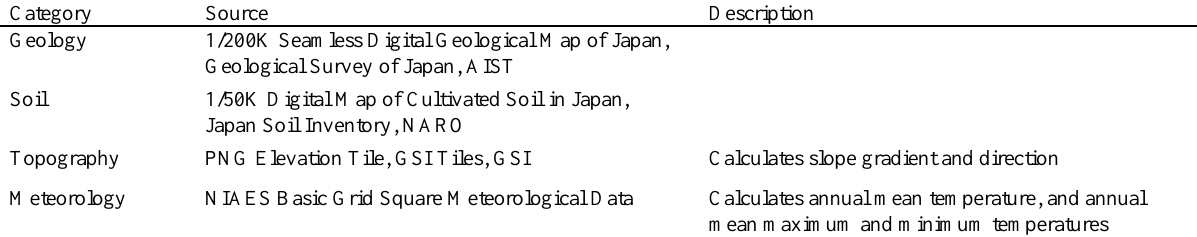
Table 1 Data categories and source to create Data Tile Map for vineyards’ suitability